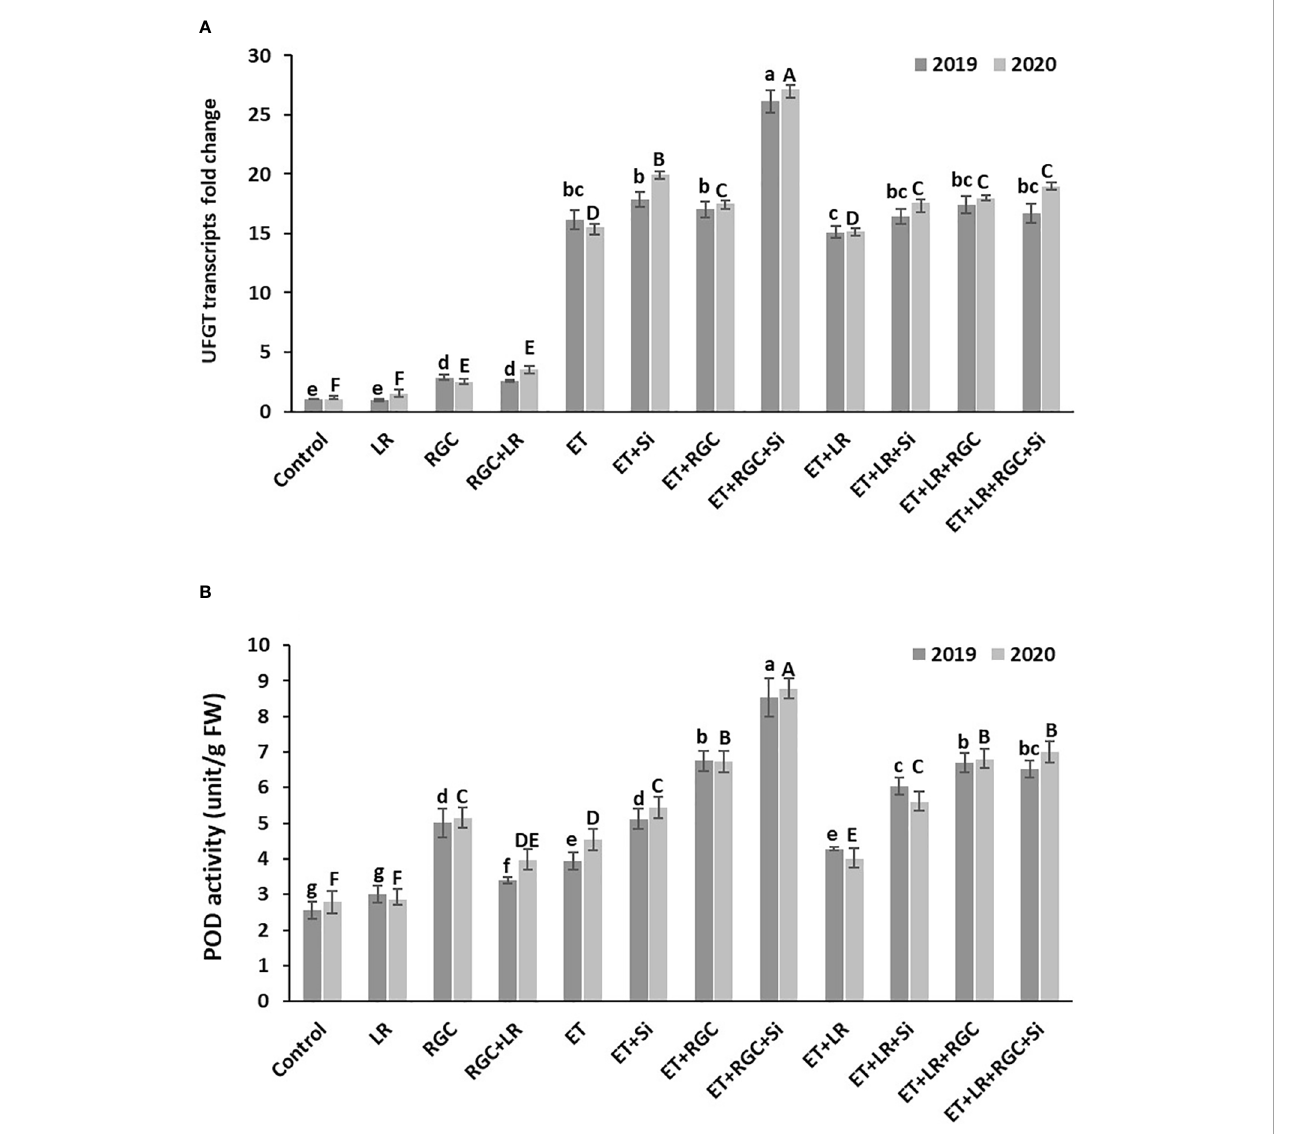
FIGURE 8 UFGT gene expression (A) and POD enzyme activity (B) affected by different treatments measured at one week after application. Treatments were: ethephon (ET), silicon 7% (Si), light-re fl ective ground cover (RGC), and their combinations. The effect of Si alone is not reported in the fi gure. Treatments have been conducted with or without cluster-zone leaf removal (LR). Values are the mean of four readings, and the error bars represent the standard deviation. Different letters on bars indicate signi fi cant differences within the same year at p < 0.05 according to the Tukey HSD test within the same season. Different lower-case letters indicate a signi fi cant difference in 2019 while capital letters are used for